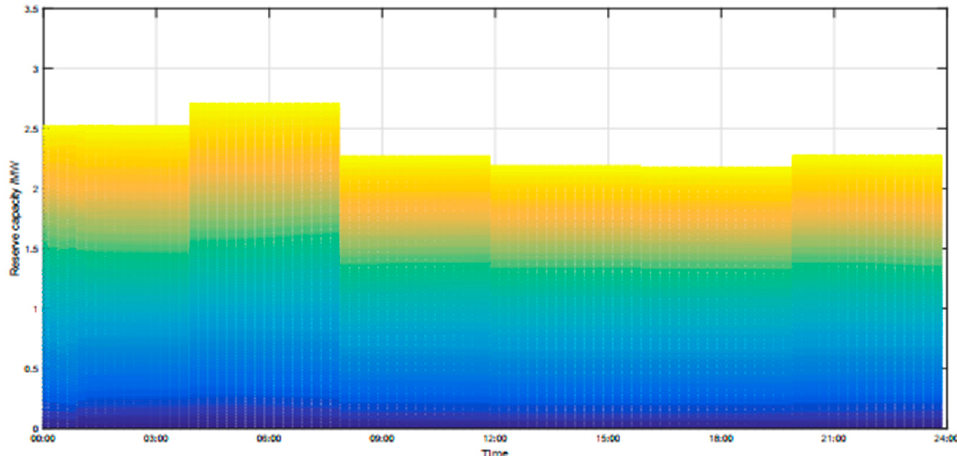
Figure 2. The aggregator’s bidding strategy in wholesale ancillary market.